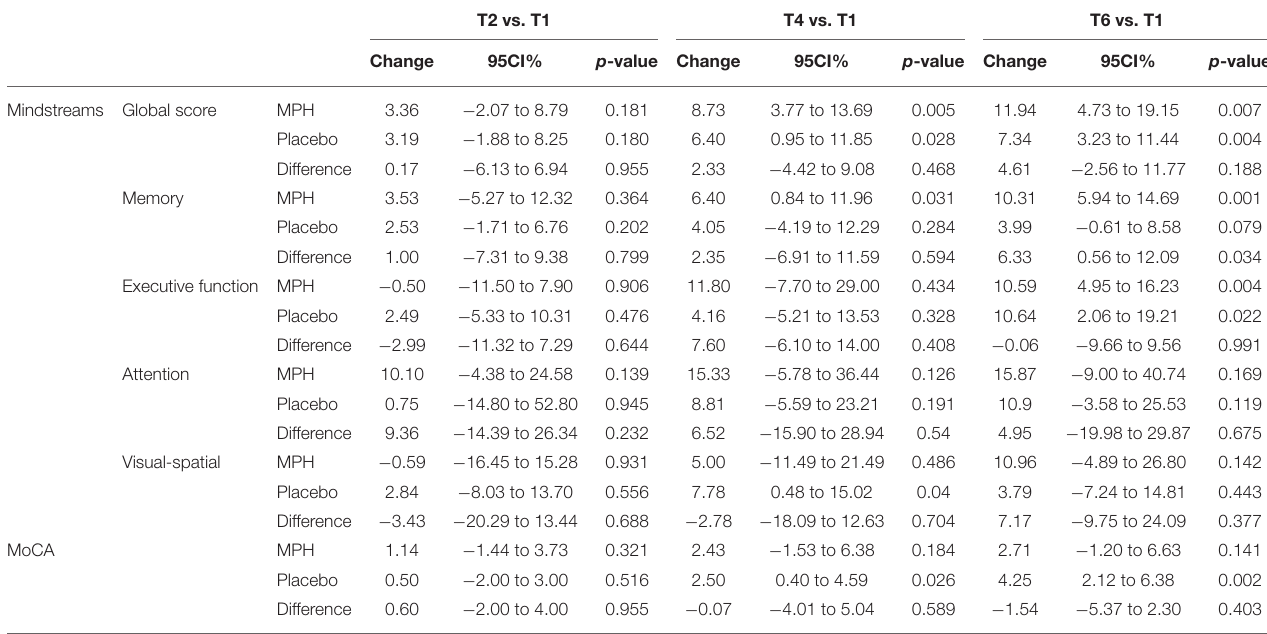
TABLE 3 | Changes in cognitive assessment during study